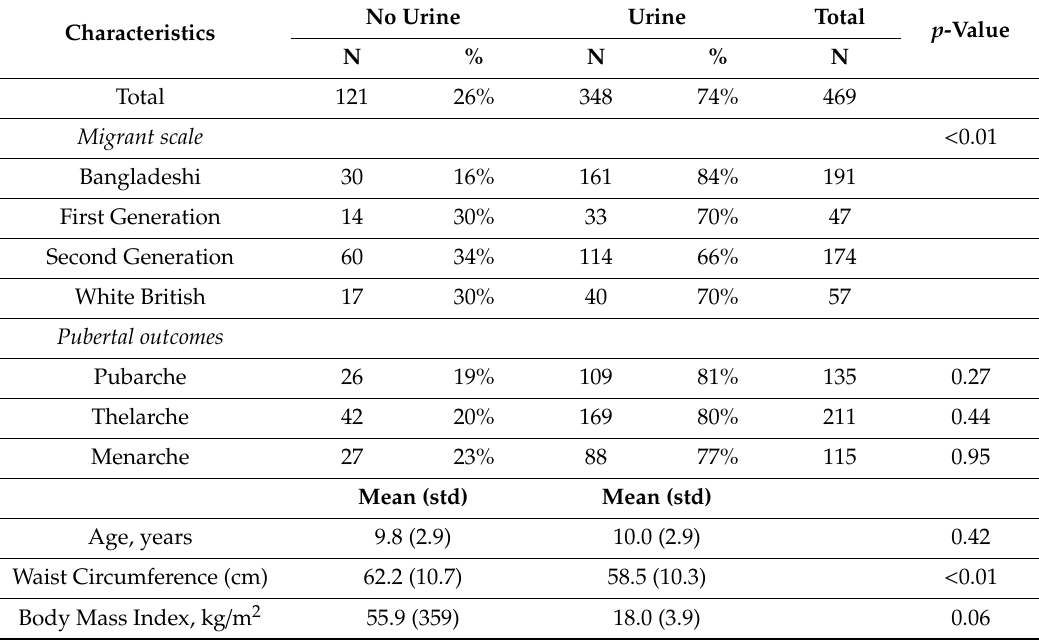
Table A1. Characteristics of girls with and without urine